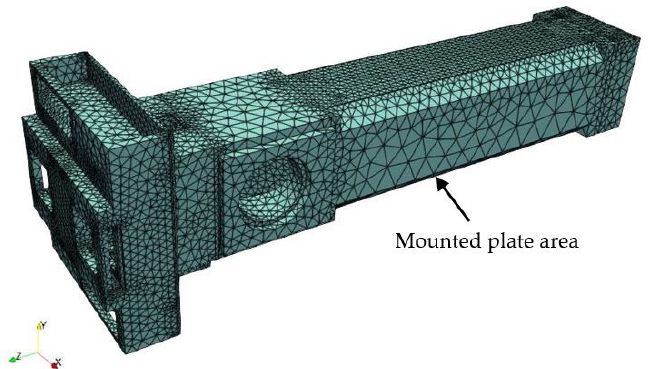
Figure 3. Meshed model of the optical laser head for the structural-thermal-optical-performance (STOP) analysis.